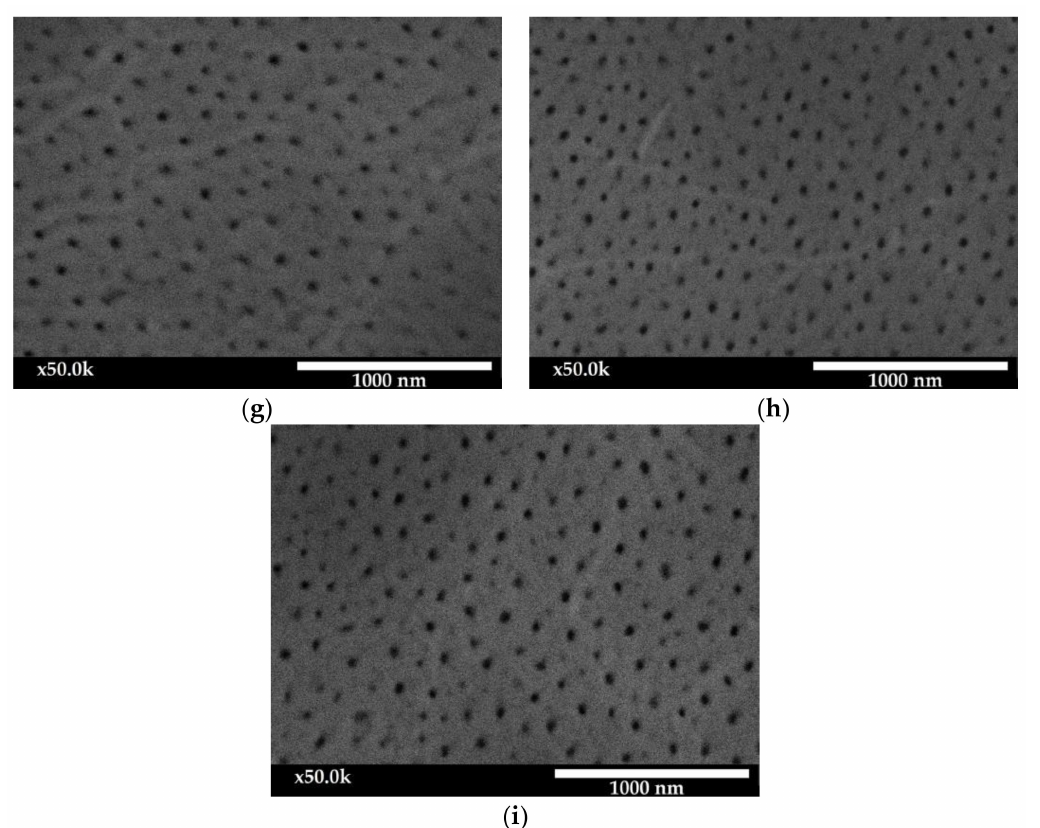
Figure 3. Images of surface morphology of oxide layer: ( a ) Sample A; ( b ) Sample B; ( c ) Sample C; ( d ) Sample D; ( e ) Sample E; ( f ) Sample F; ( g ) Sample G; ( h ) Sample H; ( i ) Sample I.